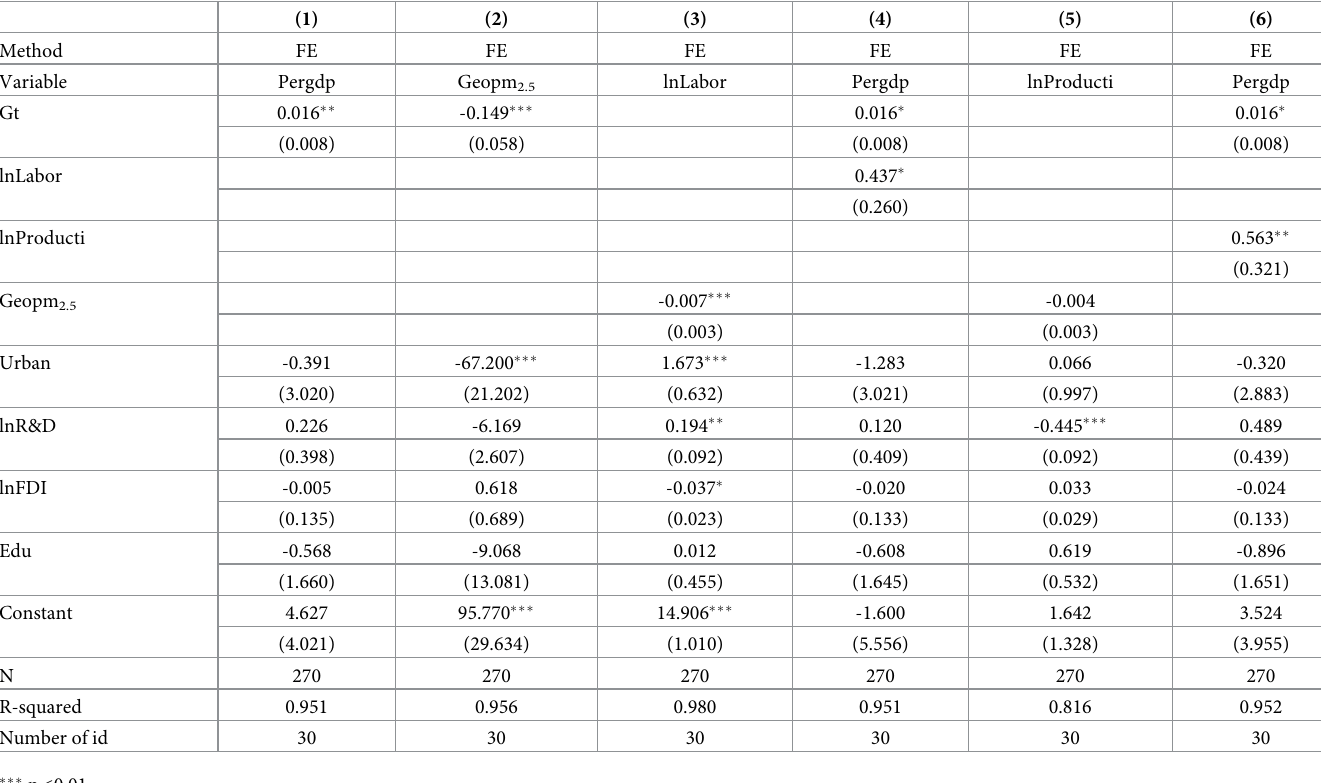
Table 2. Estimation of the mediating effect at the national